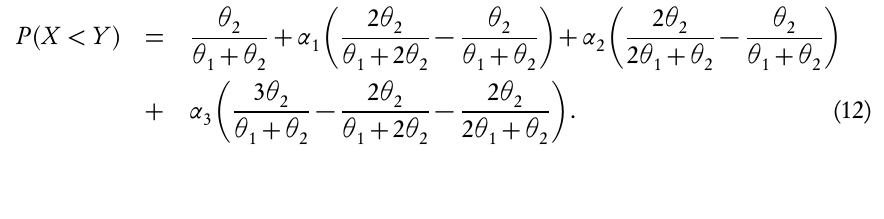
, α for CTBE ( − 0.2, α 2 3